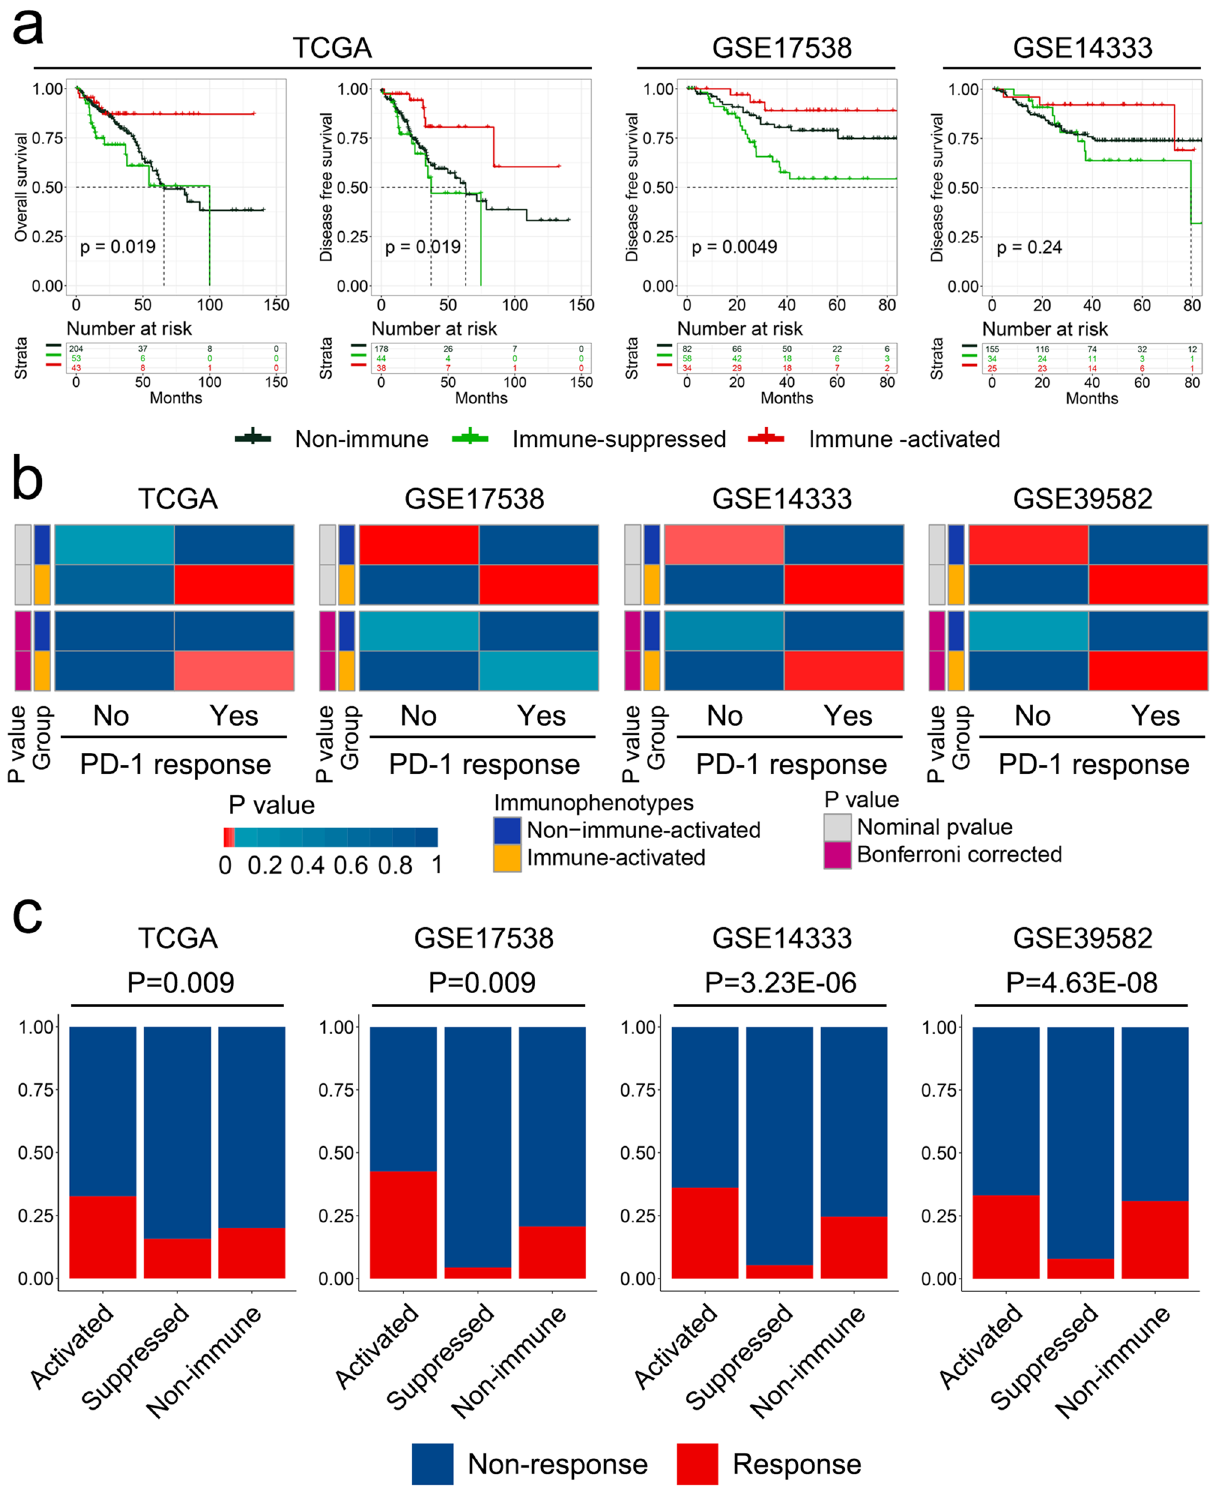
Figure 5. Immune-related molecular subtypes associated with prognosis and response to immune checkpoint inhibitor (ICI) therapy. ( a ) Kaplan–Meier analysis showing different overall and disease-free survival with three immunophenotypes in the training and validation cohorts. ( b ) Subclass mapping analysis indicates that patients in the immune-activated subclass show similarity with patients who respond to anti-PD-1 treatment. ( c ) Tumor immune dysfunction and exclusion analysis showing ICI response ratios among the three